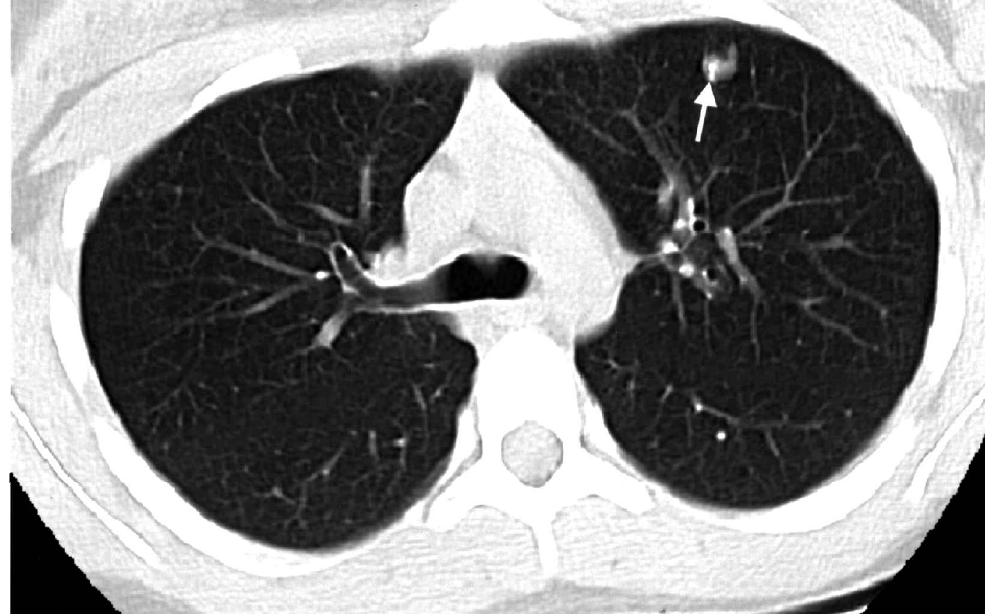
Figure 3. A 16-year-old female with osteosarcoma of distal femur diagnosed 3 years earlier. Helical CT shows 1 3 0.8 cm partly calci® ed pulmonary nodule (arrow) in left upper lobe. Histopathological examination of wedge resection specimen showed osteogenic sarcoma (50% viable